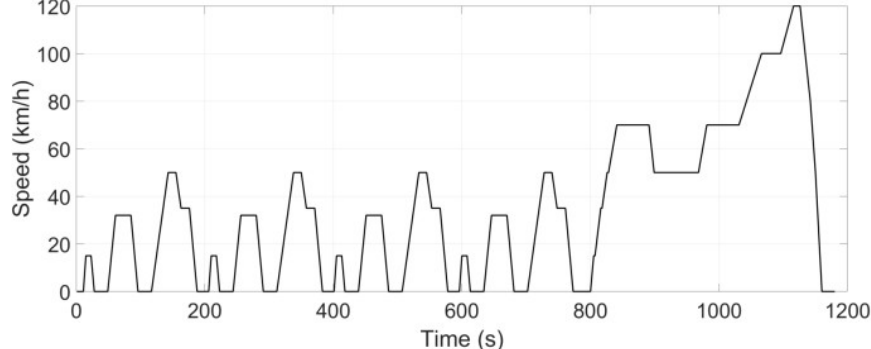
Figure 5. NEDC test cycle.